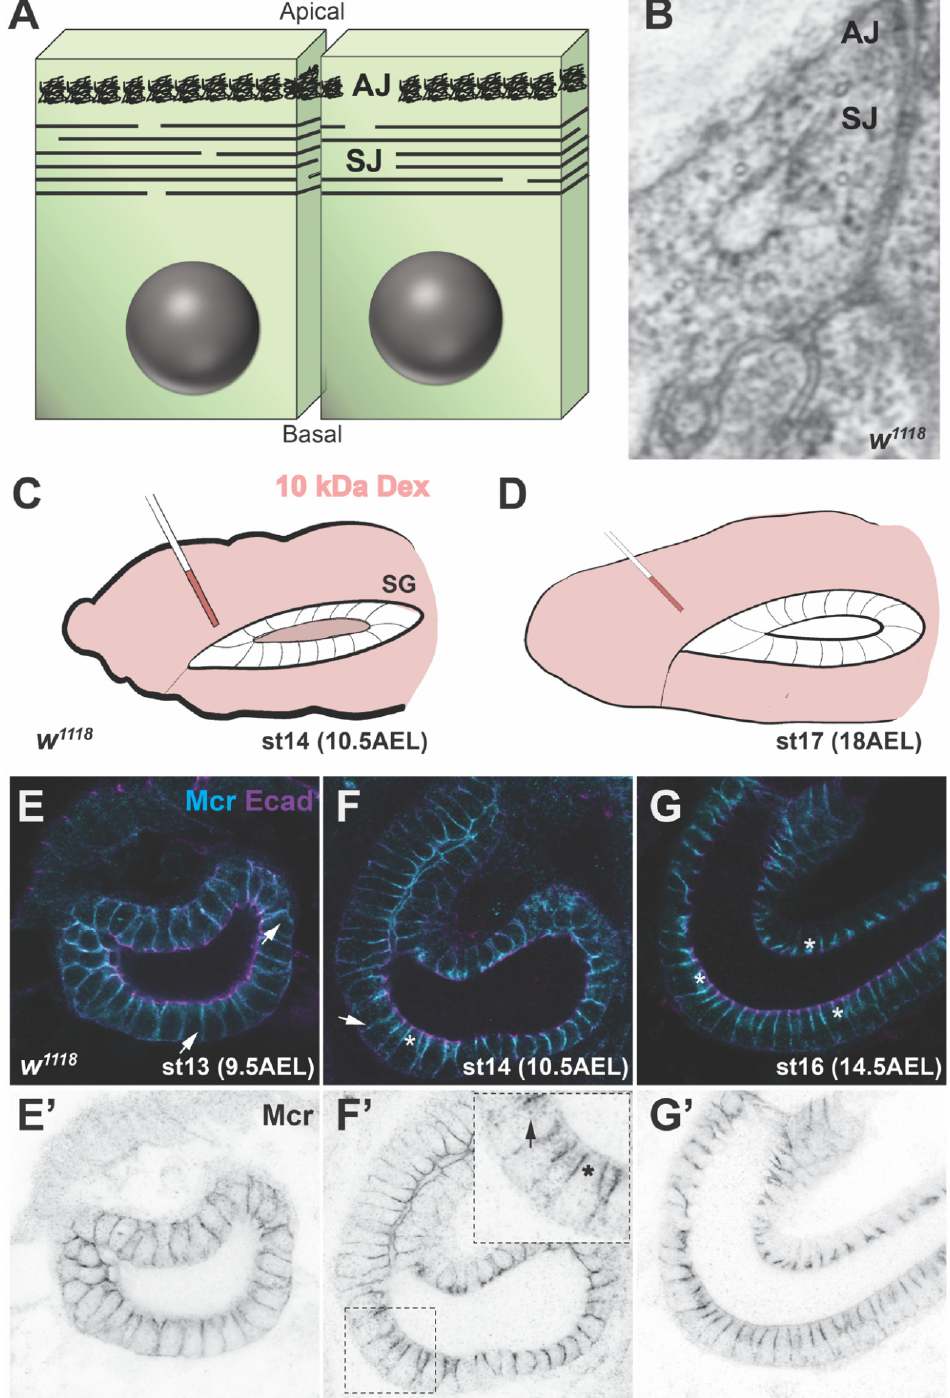
Figure 1. Structure and biogenesis of SJs. ( A ) Diagram of a polarized epithelium, showing the location of the adherens junction (AJ) and the septate junction (SJ). Apical is to the top. Note that the septa do not completely encircle the cell but are discontinuous, generating an extended path from the apical to basal side of the epithelium. ( B ) Electron micrograph of the epidermis in a stage 17 wild type embryo showing the electron dense extracellular septa in the SJ. ( C , D ) Diagram of the anterior portion (including a salivary gland) of a stage 14 ( C ) and a stage 17 ( D ) wild type embryo that